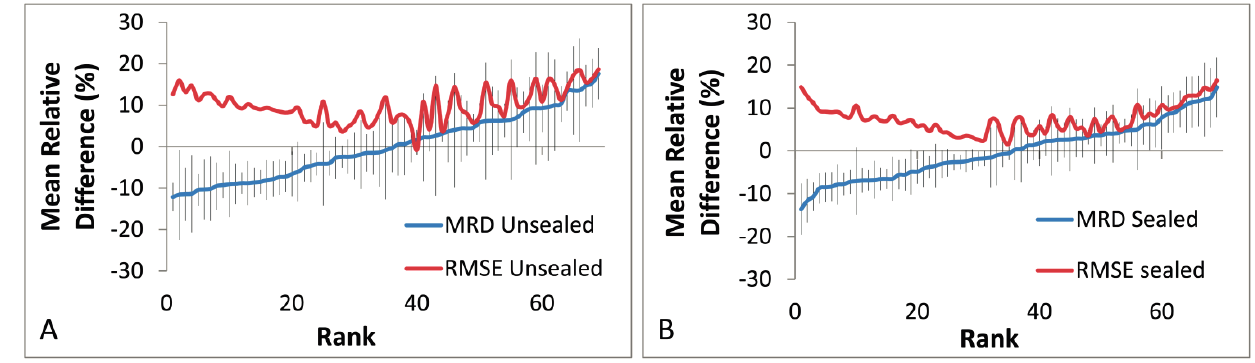
Figure 6. Rank-ordered temporal stability characteristics of the unsealed ( A ) and sealed ( B ) systems. The mean relative differences (MRD) and error bars that represent one standard deviation are marked in blue. RMSE values are shown in